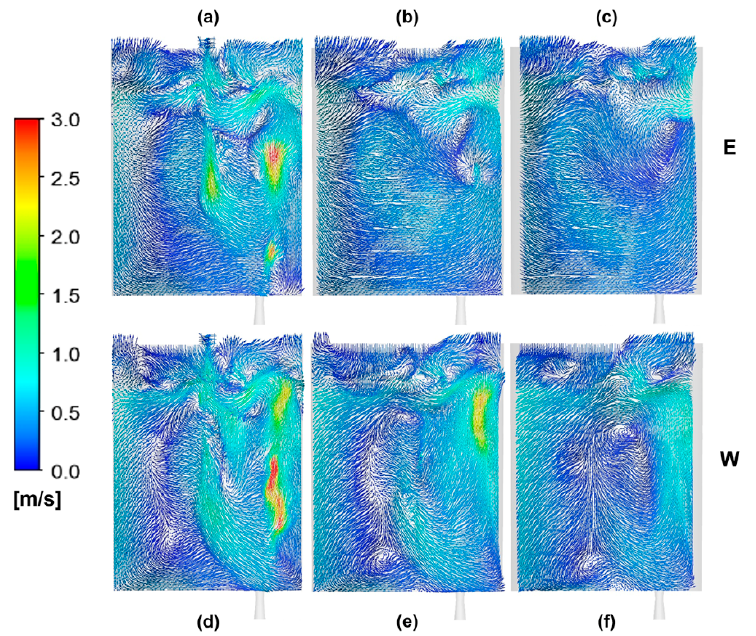
Figure 8. Velocity fields in planes East and West sectors at a bath level of 80 tons. ( a ), ( b ) and ( c ), correspond to the East sector, respectively. ( d ), ( e ) and ( f ), correspond to the West sector, respectively.